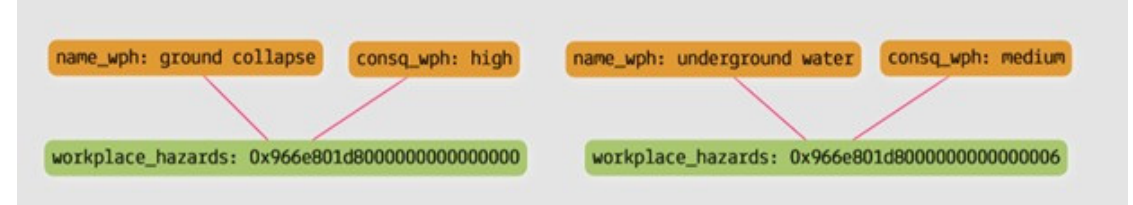
Figure 11. The result of Query 2, in a graph form.